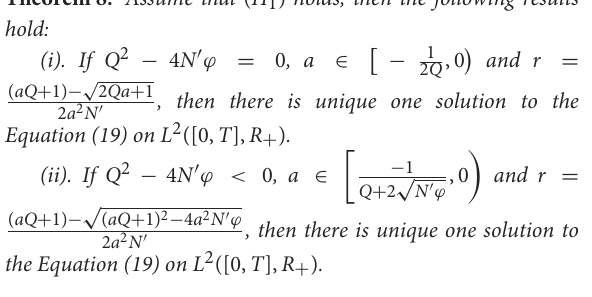
FIGURE6 Schematic illustration of the algorithm